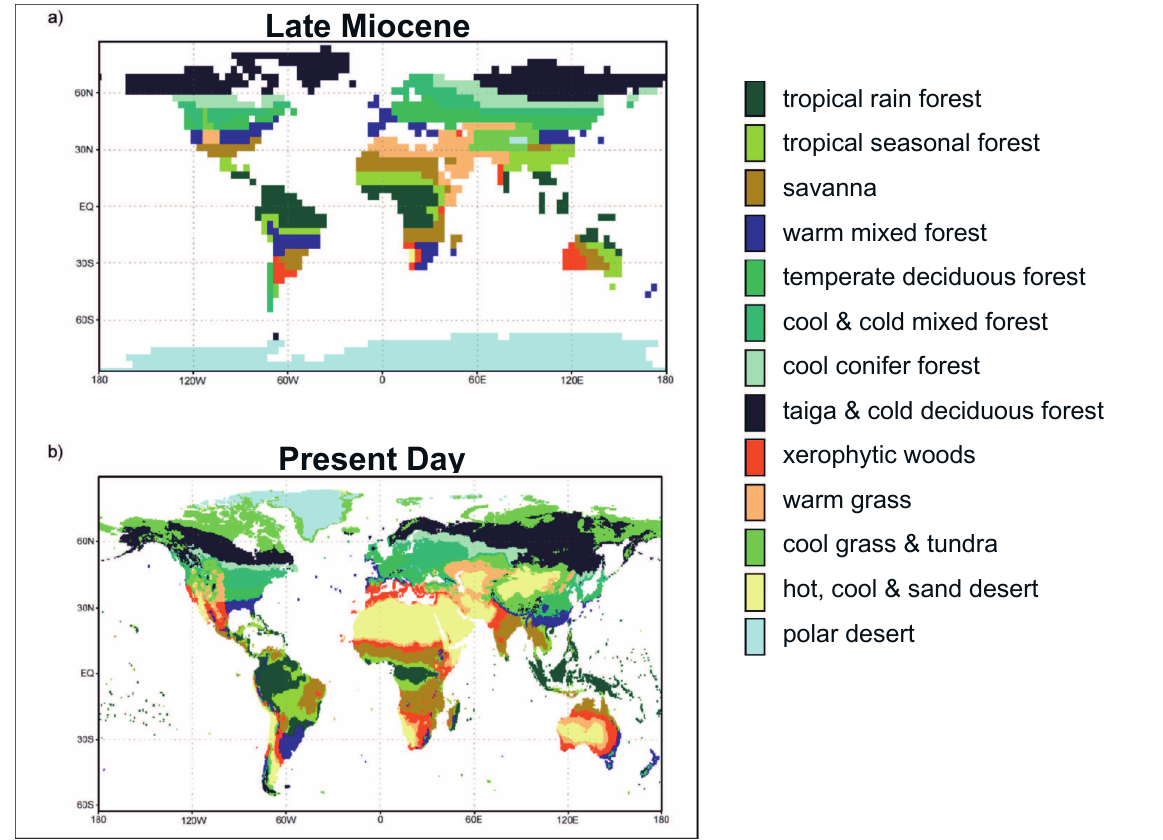
Figure 1. ( a ) The proxy-based reconstructed Tortonian vegetation; and ( b ) the present-day’s vegetation (New et al. , 1999) [42]. These maps serve as an input into the atmospheric general circulation model (AGCM) experiments TVEG ( a ), TGEO ( b ) and CTRL ( b ). Warm grass corresponds to subdesertic Mediterranean-like open